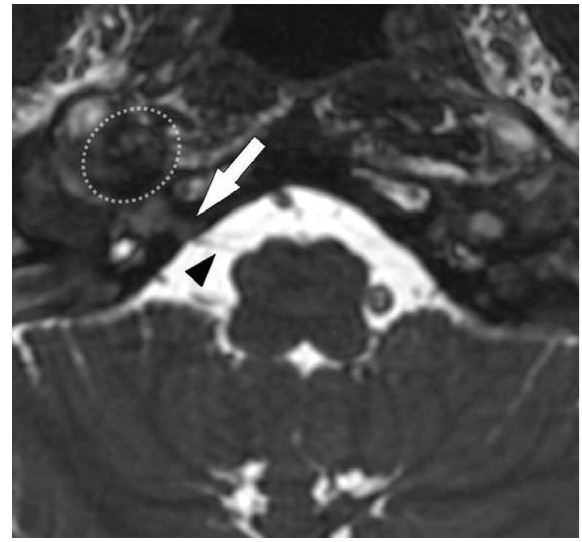
Figure 2: Axial steady-state free procession MR image through the skull base shows the hypoglossal nerve (arrowhead) passing through the hypoglossal canal (arrow). Te osteophyte (dashed oval) lies just anterior to the hypoglossal canal, along the expected path of the hypoglossal